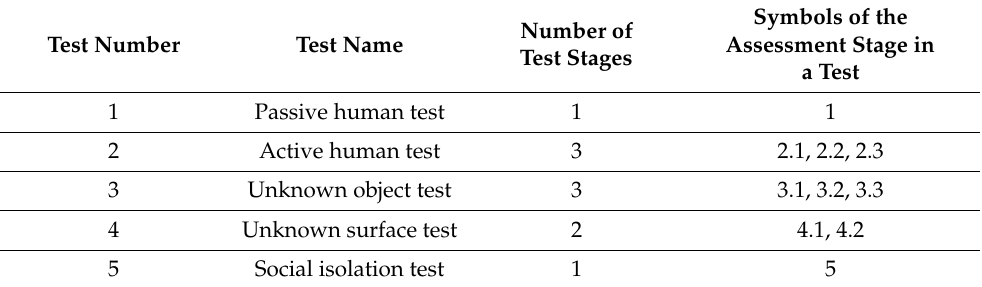
Table 1. A list of behavioural tests